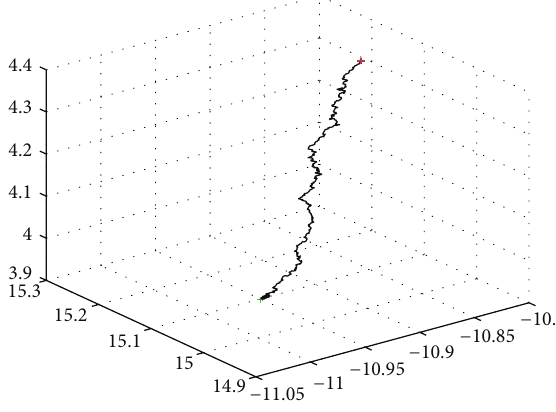
Figure 1: The climb process with climb step 0.001 and climb number 1000 for solving 𝑓(𝑥) = 𝑥 2 in the 3d space.